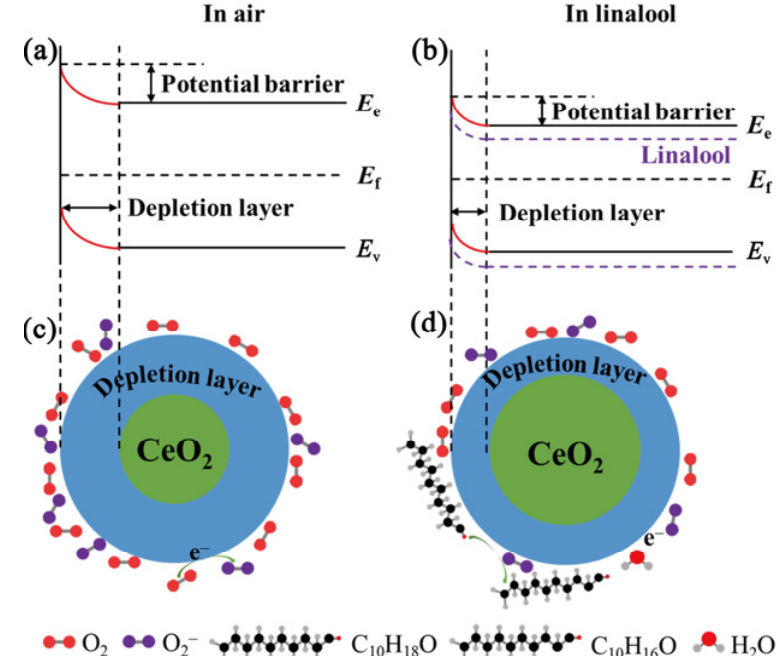
Fig. 6 Schematic illustration of RT sensing mechanism of S3 towards ppm-level linalool: (a, c) in air; (b, d) in linalool ( E c : conduction band bottom; E f : Fermi level; E v : valence band